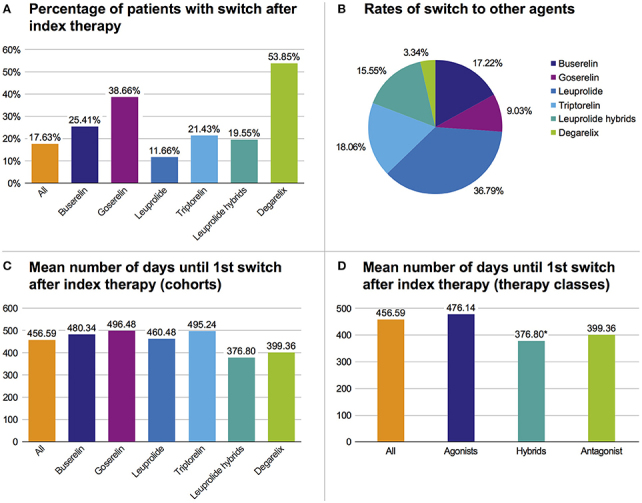
Overview of therapy switches. (A) Percentage of patients with switch after index therapy. (B) Rates of all switches to one of the six cohorts. (C) Mean number of days until first switch after index therapy based on cohorts. (D) Mean number of days until first switch after index therapy based on pooled therapy classes, *p < 0.05 vs. agonists.